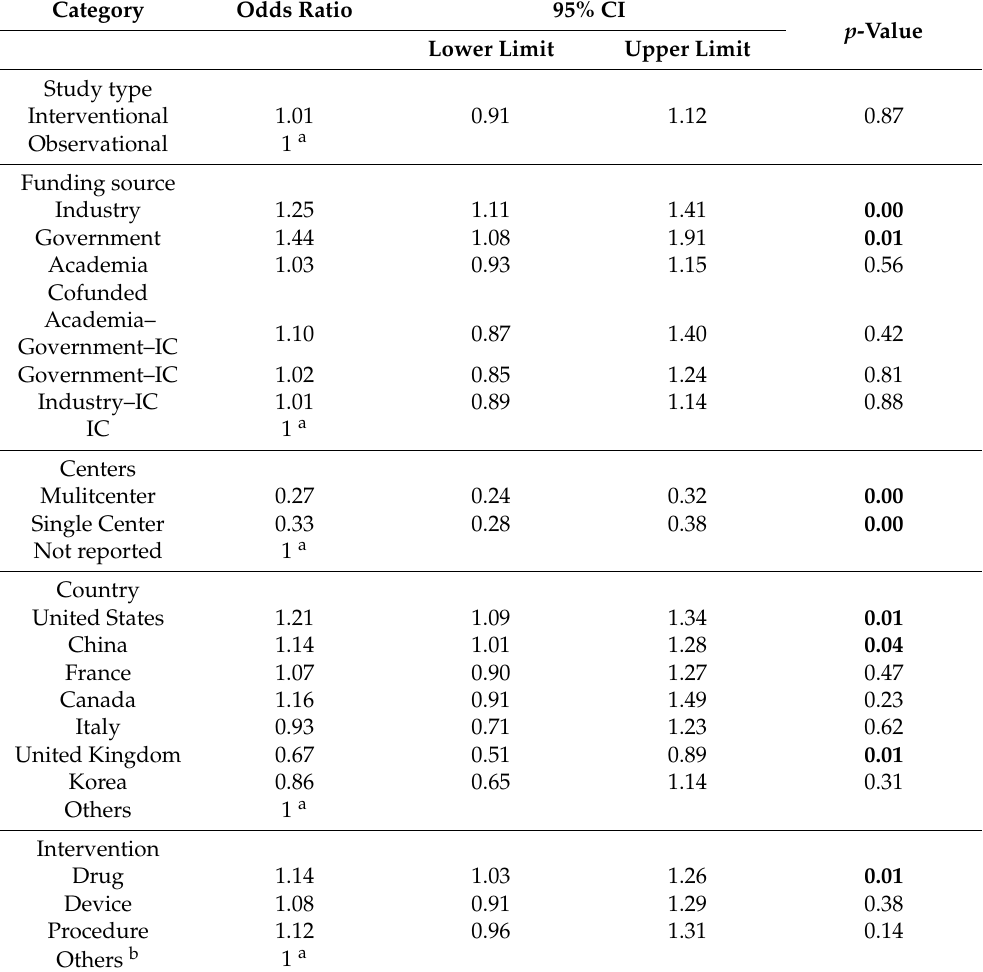
multivariable logistic regression